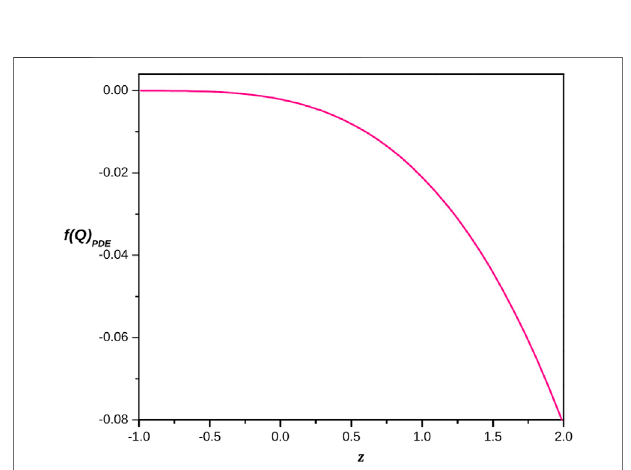
FIGURE 8 | Plot of reconstructed pilgrim dark energy f ( Q ) gravity model versus redshift for the appropriate choice of constants c 2 = 0.0018 and c 3 =